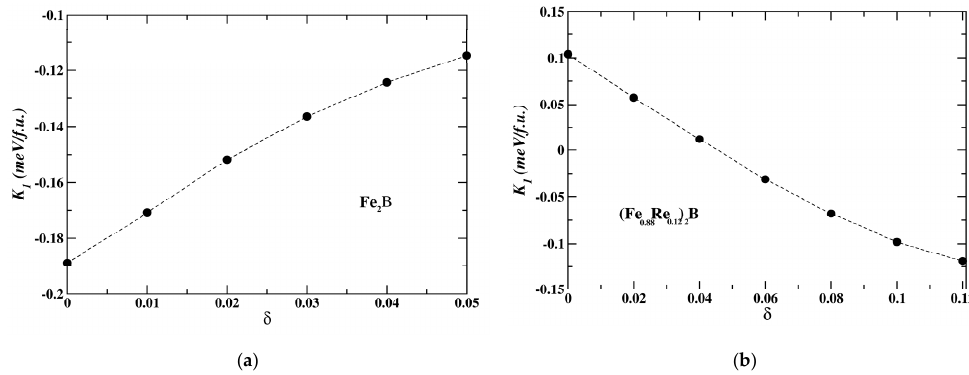
Figure 6. (a) Disorder e ff ects on anisotropy constant K 1 of the Fe 2 B alloy. (b) Disorder e ff ects on Figure 6. ( a ) Disorder effects on anisotropy constant K 1 of the Fe 2 B alloy. ( b ) Disorder effects on anisotropy constant K 1 of (Fe 0 . 88 Re 0 . 12 ) 2 B alloys. Mixing of δ atoms of Fe/B and Re/B has been consid- anisotropy constant K 1 of (Fe 0.88 Re 0.12 ) 2 B alloys. Mixing of δ atoms of Fe/B and Re/B has been ered between 8h and 4a crystallographic sites, respectively. considered between 8h and 4a crystallographic sites, respectively.